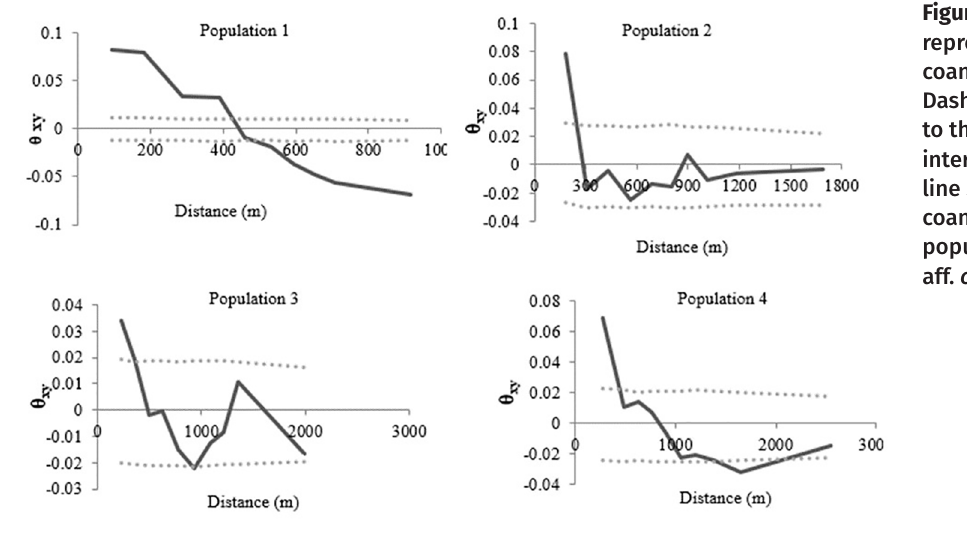
Figure 5. Graphical representation of the coancestry coefficient. Dashed lines correspond to the 95% confidence interval, and solid line shows the coancestry coefficient in populations of Guadua aff. chaparensis